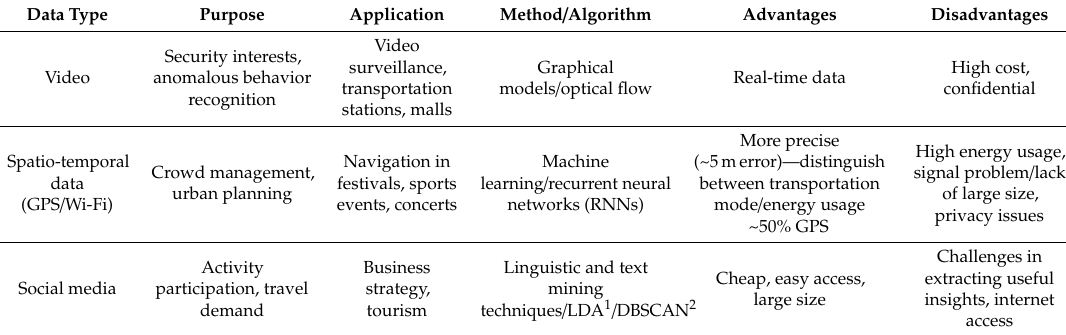
Table 3. Comparative summary of the di ff erent data types in crowd flow